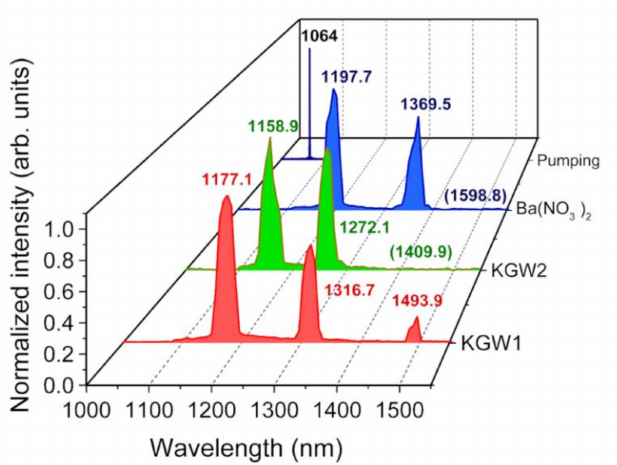
Figure 2. The calculated Stokes wavelengths (numerical value) and the detected spectra (figure) of the Stokes lasers at the pumping energy of 120 mJ. The calculated Stokes wavelengths of 1409.9 and 1598.8 nm are not detected in the